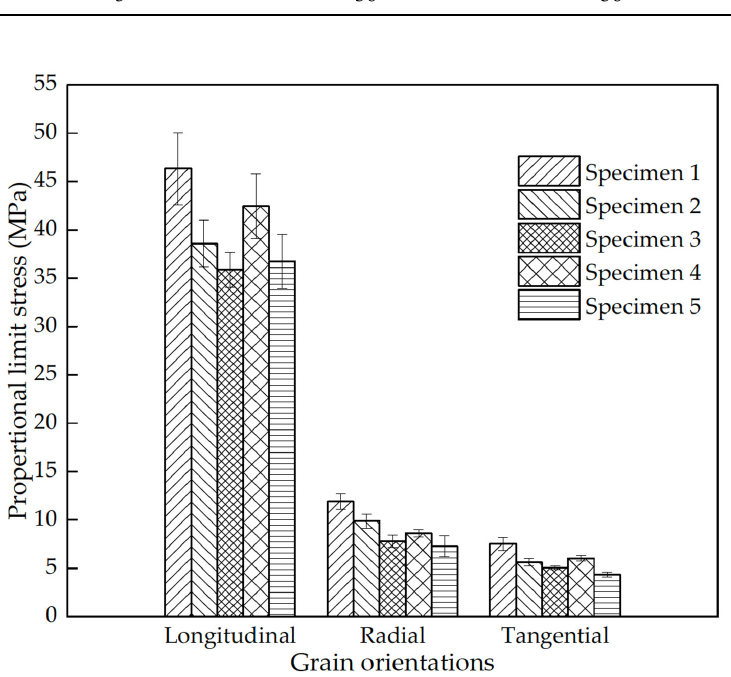
Table 2. Key to the specimen dimensions for which data are plotted in Figure 49. From [134].